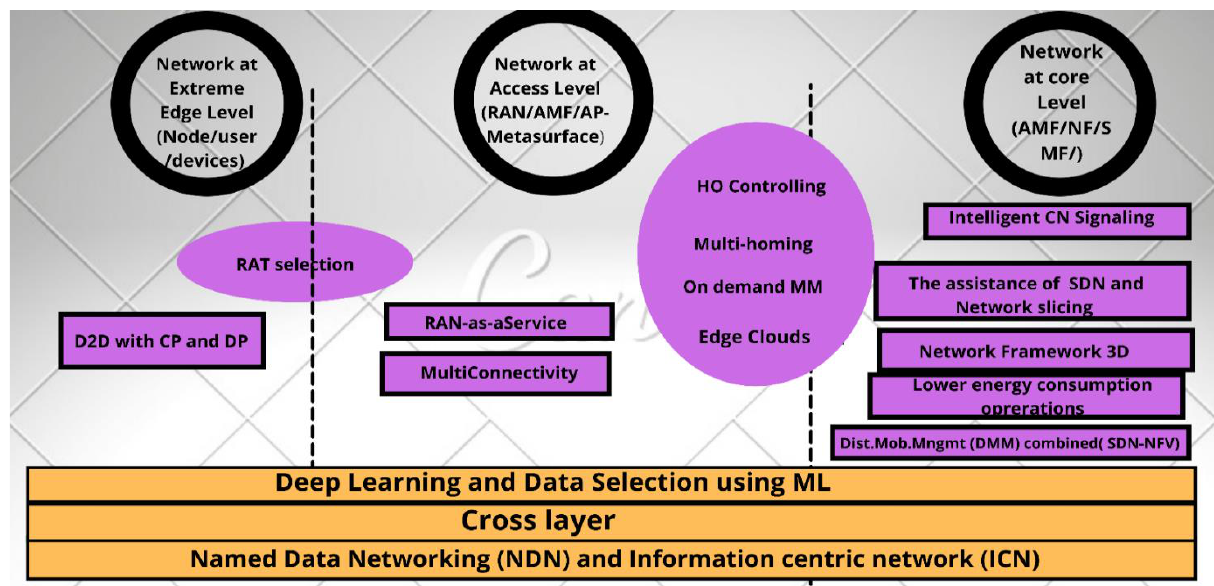
Figure 2. Future 6G MM structure.